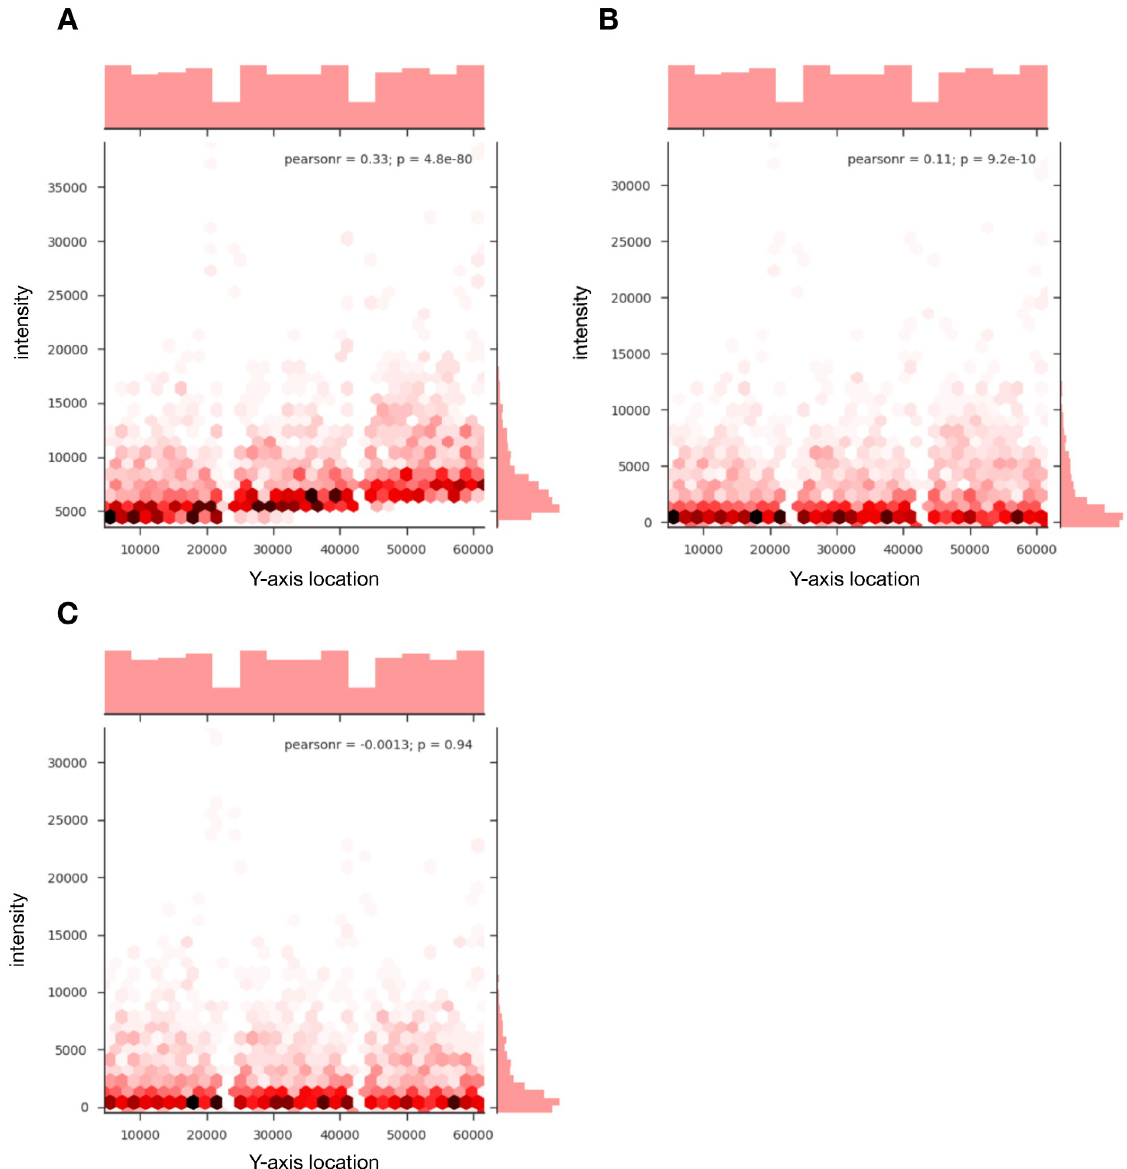
Fig 4. Background scaling to account for regional variations. A. Uncorrected output from an array showing a high degree of bias, creating a correlation between probe foreground intensity and the spot location on the y-axis of the array. B. Output from the same array as A, corrected using background subtraction. The bias has reduced substantially, but there still is a discernible and statistically significant correlation, especially in the probes with higher intensities. C. Output from the same array as A and B, corrected using background scaling, completely removing the correlation between probe intensity and y-axis. Data represents an array taken from the TLR4 experiment described earlier that is neither an outlier nor required any manual alignment correction (mean/median slope > 0.85). Frequency histograms along the x-axis show the distribution of the position of spots on the array (identical for all three panels). Frequency histograms along the y-axis show the distribution of intensities which concentrate at lower values when correction is applied.